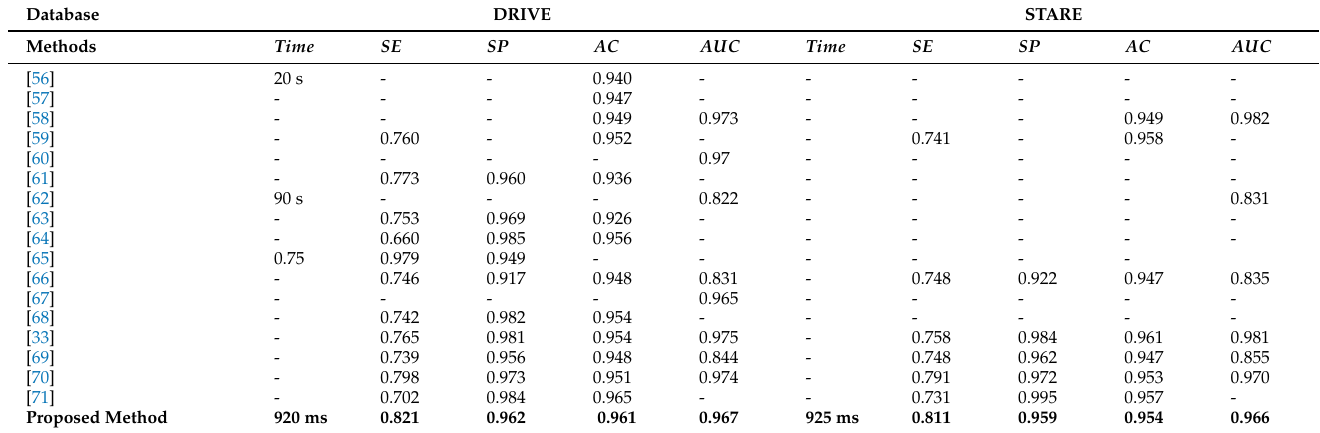
Table 8. Comparison of Proposed Segmentation Methods with CNN-Based learning